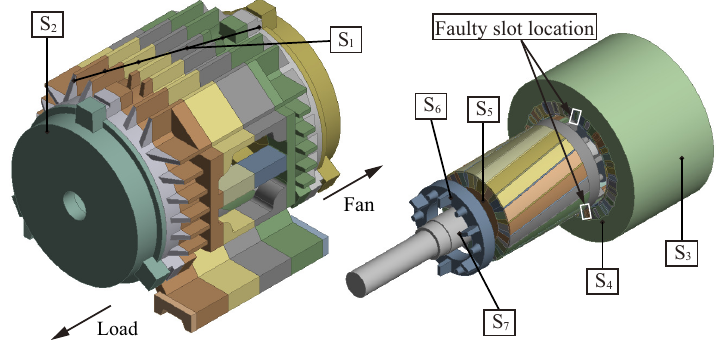
Figure 2. Simulation model of the motor thermal